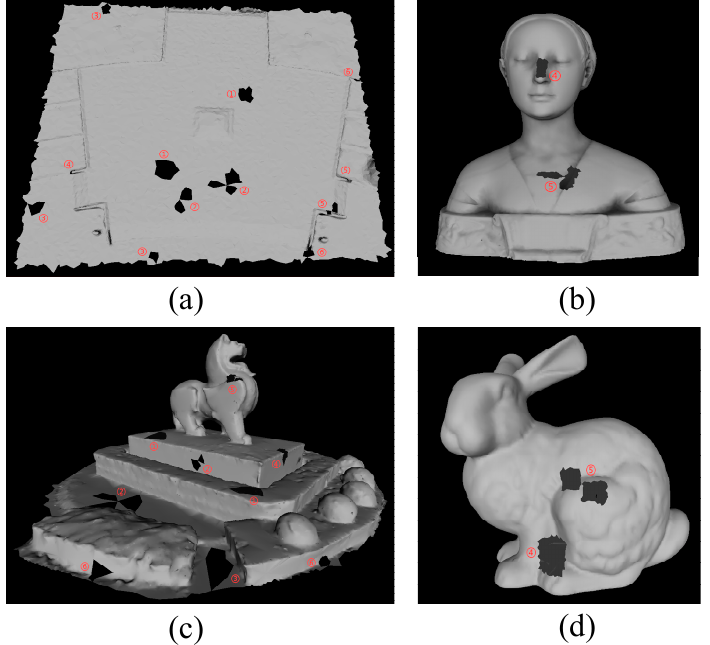
Figure 1. Different types of holes in the models: ( a ) WCGC-S model with holes, ( b ) Laurana model with holes, ( c ) Pixiu model with holes, and ( d ) Bunny model with holes.